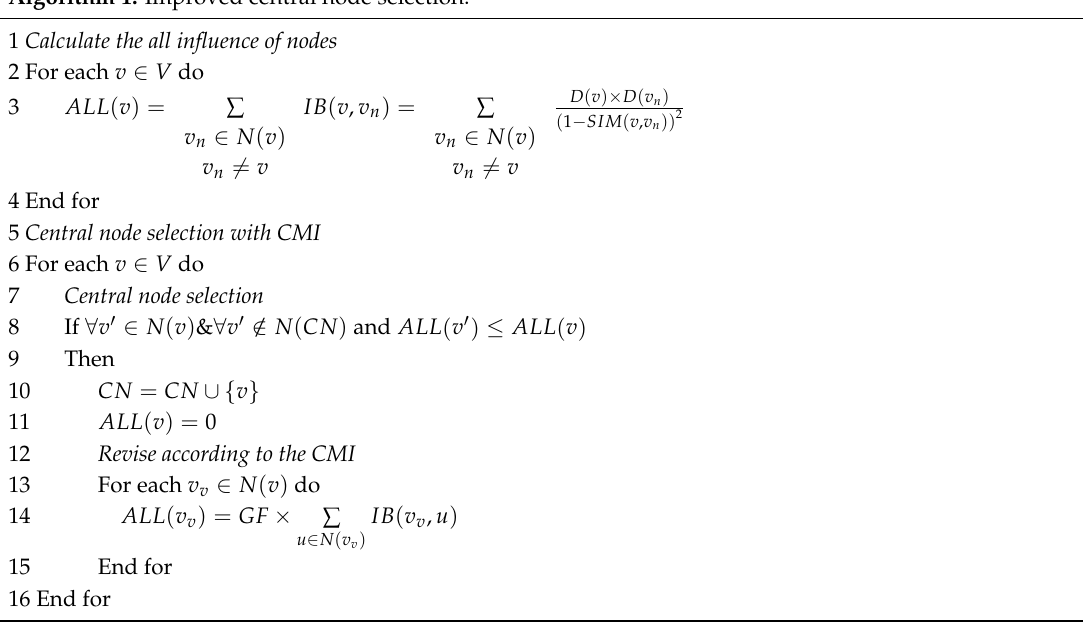
Algorithm 1. Improved central node